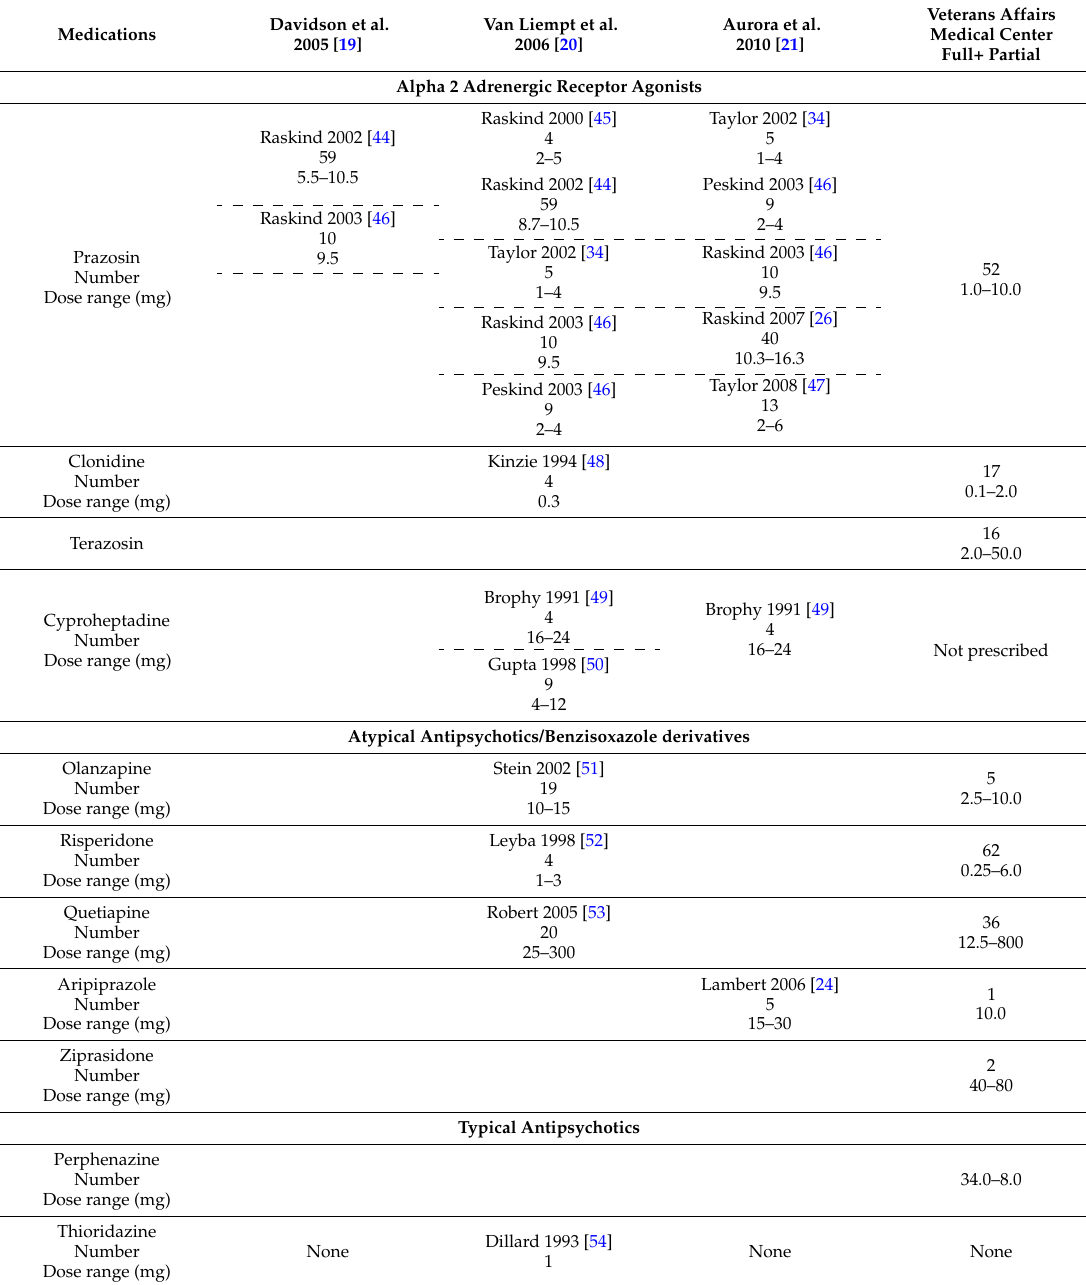
Table 3. Combat nightmares: successful medication dose ranges in three literature reviews.